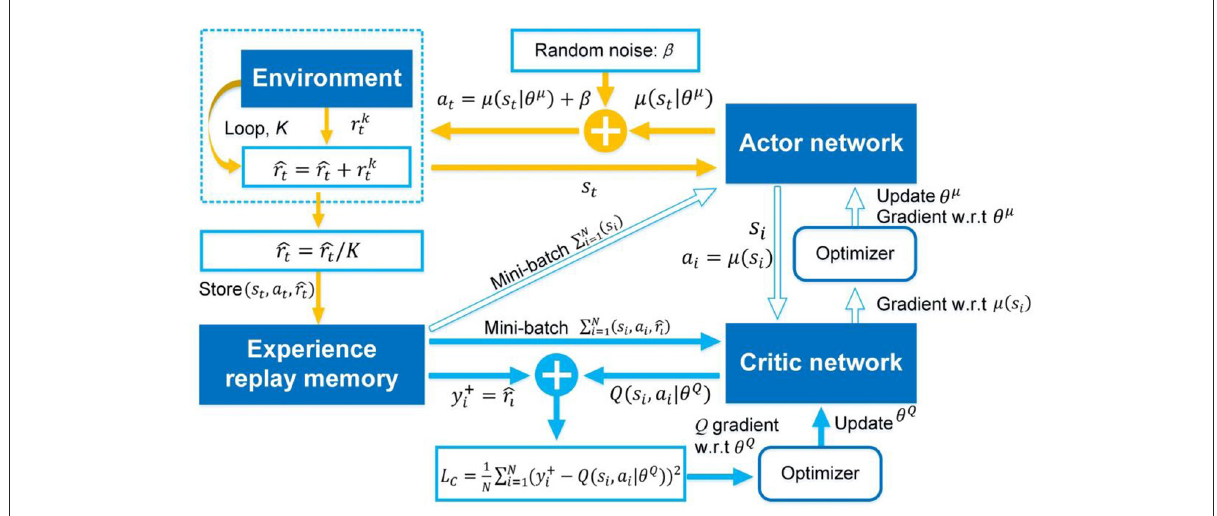
FIGURE1 The framework of the immediate-return RL algorithm. Yellow solid arrows: the actor network interacts with the environment. Blue solid arrow: update for critic network. Blue hollow arrow: update for actor network.